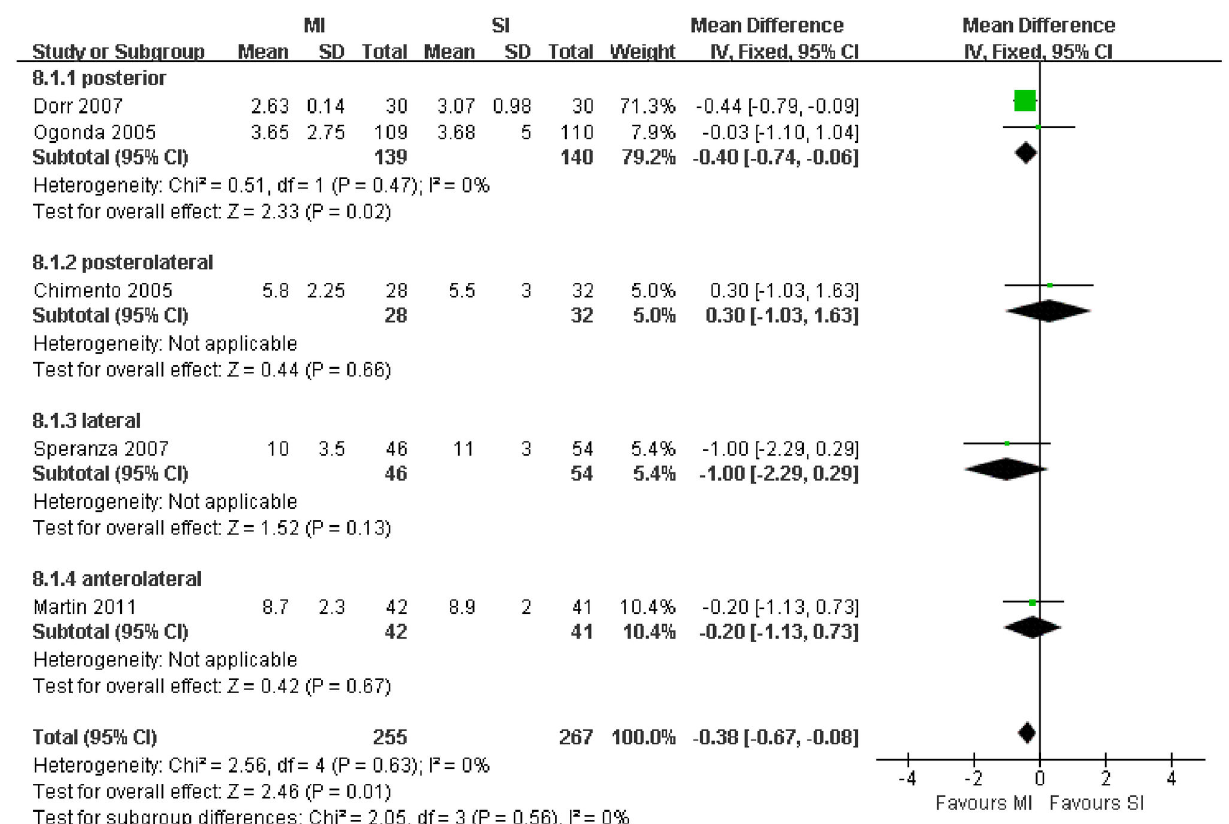
Figure 6. Meta-analysis of randomized controlled trials evaluating length of hospital